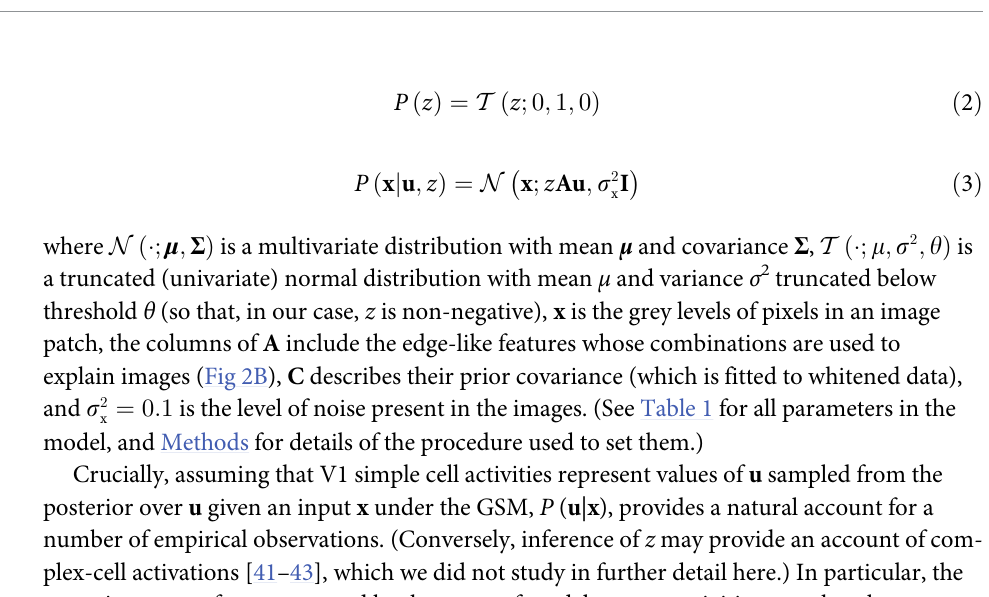
Fig 2. A. The graphical model representation of the Gaussianscale mixture model. The distribution over the observations (images), x , dependson two latent variables, z and u . The vector u represents the intensity of edge-likefeatures (see panel B) in the images. The positive scalar z represents the overallcontrast level in the image. B. The basis functions represented by u were 15 Gabor filters centred at five different locations,and with three different